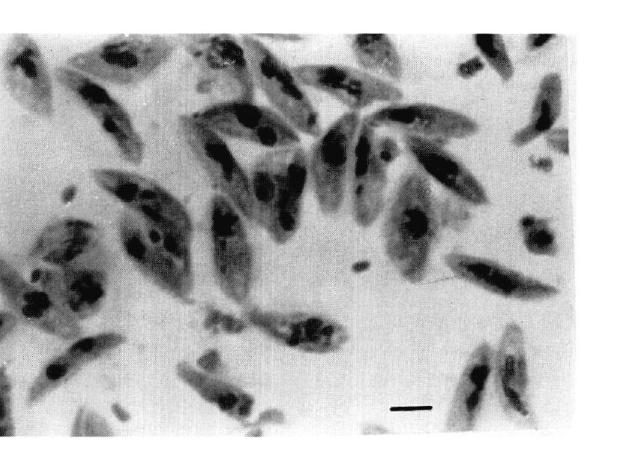
Fig. 1. - Light micrograph of purified sexual blood stage-parasites from in vitro cultures of P. falciparum. The parasites were stained with Giemsa and examined under light microscope. The bar repre sents 10 urn.